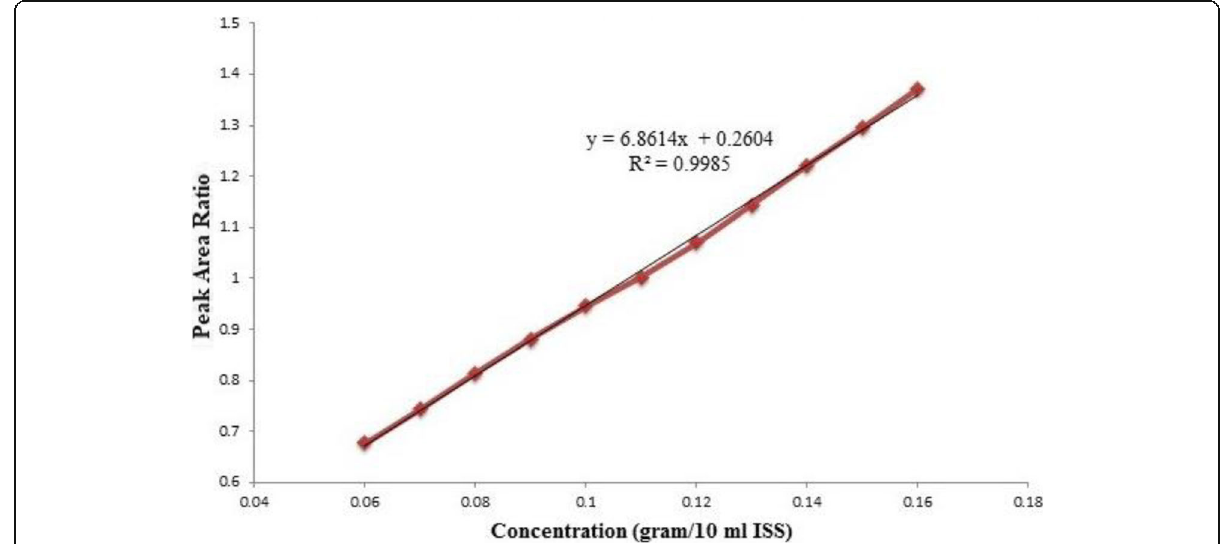
Fig. 2 Linearity graph showing the relation of bifenthrin concentration and peak area ratio